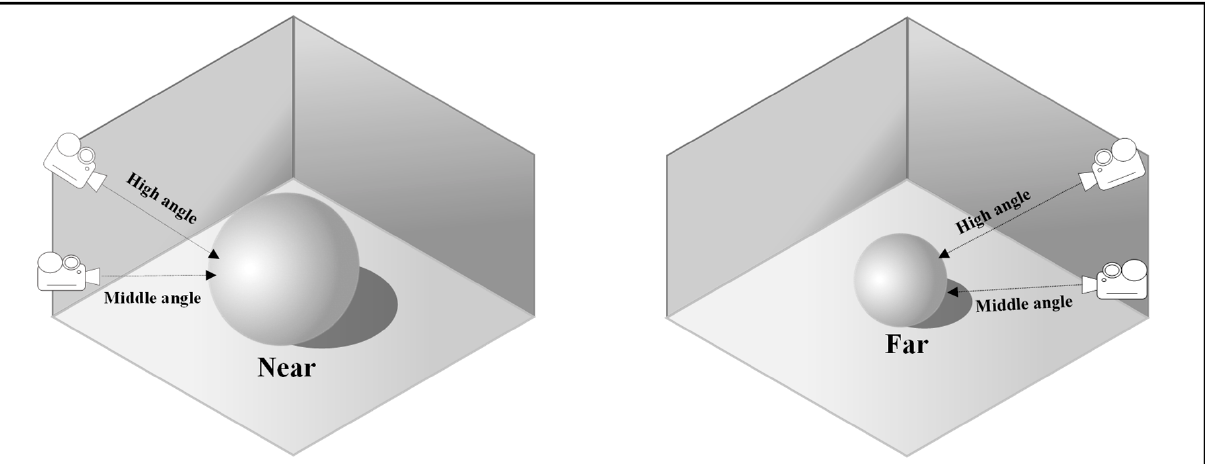
Figure 5. Based on perspective and shooting angle.